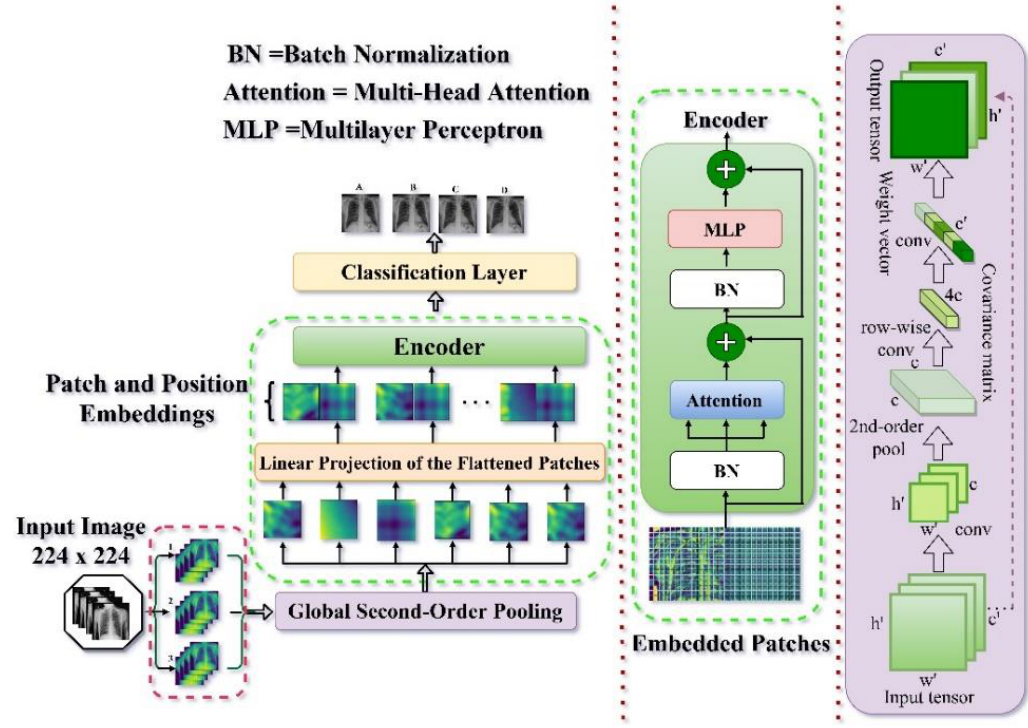
Figure 2. The proposed model organizational structure. The DenseNet201 (shown with 1), VGG16 (shown with 2), and GoogleNet architecture (shown with 3) serve as the network backbone to help in feature extraction. The fused features are passed via a global second-order pooling before being split into N patches and linear projection is employed to embed them. After adding position embedding, the sequence is supplied to an encoder, which then passes it to the classification/detection layer for prediction.